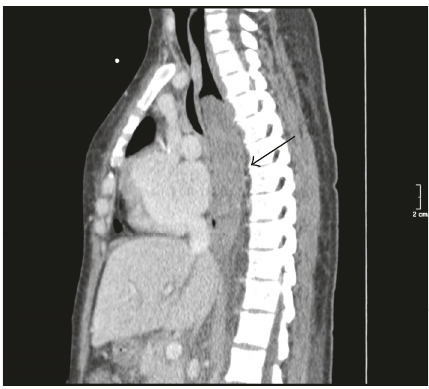
Figure 2: Second post-C-section day chest CT sagittal view of the esophageal hematoma (black arrow) infiltrating the posterior